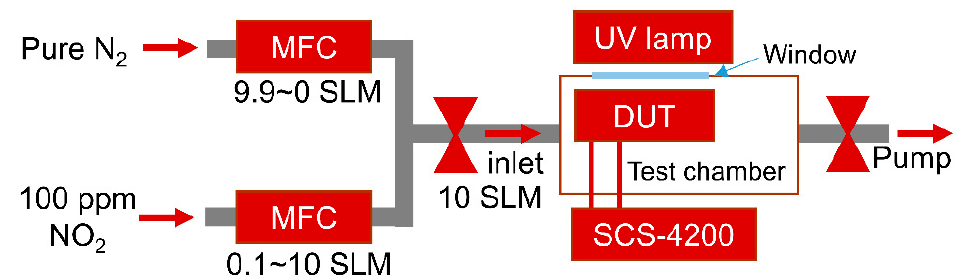
Figure 2. Schematic diagrams of the gas sensing measurement